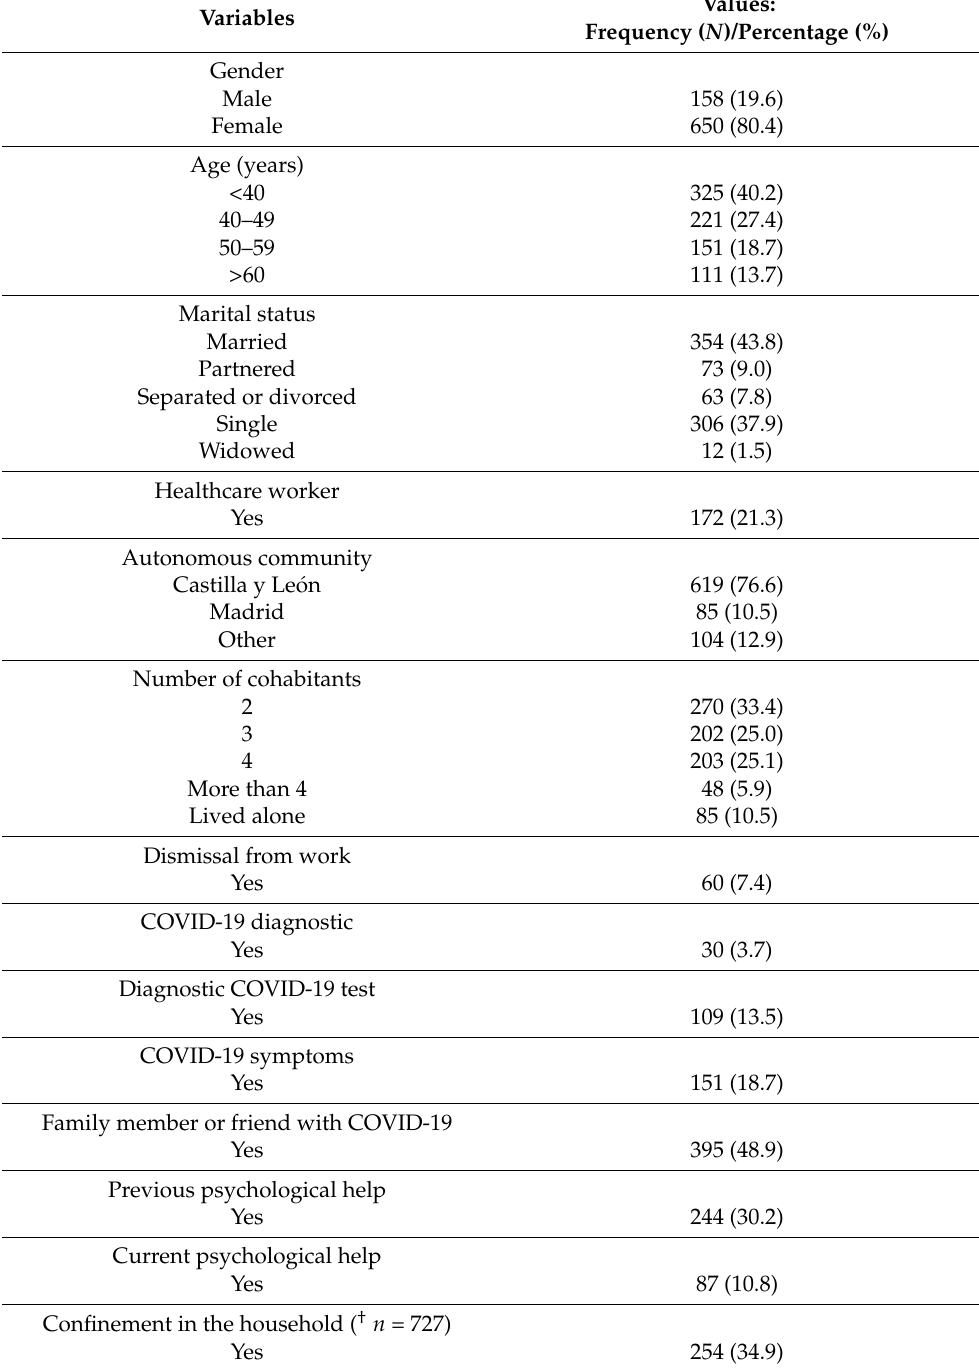
Table 1. Frequency distribution and percentages of general variables (* N = 808), Spain,